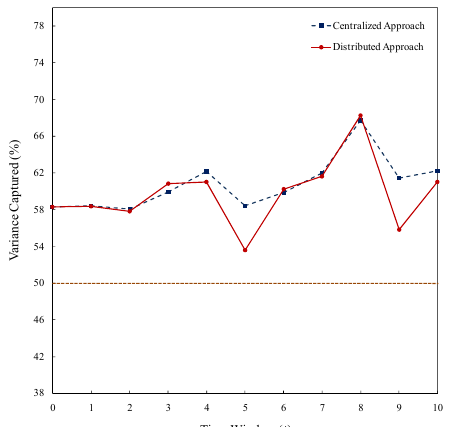
Figure 7. The percent variance captured by each principal component.